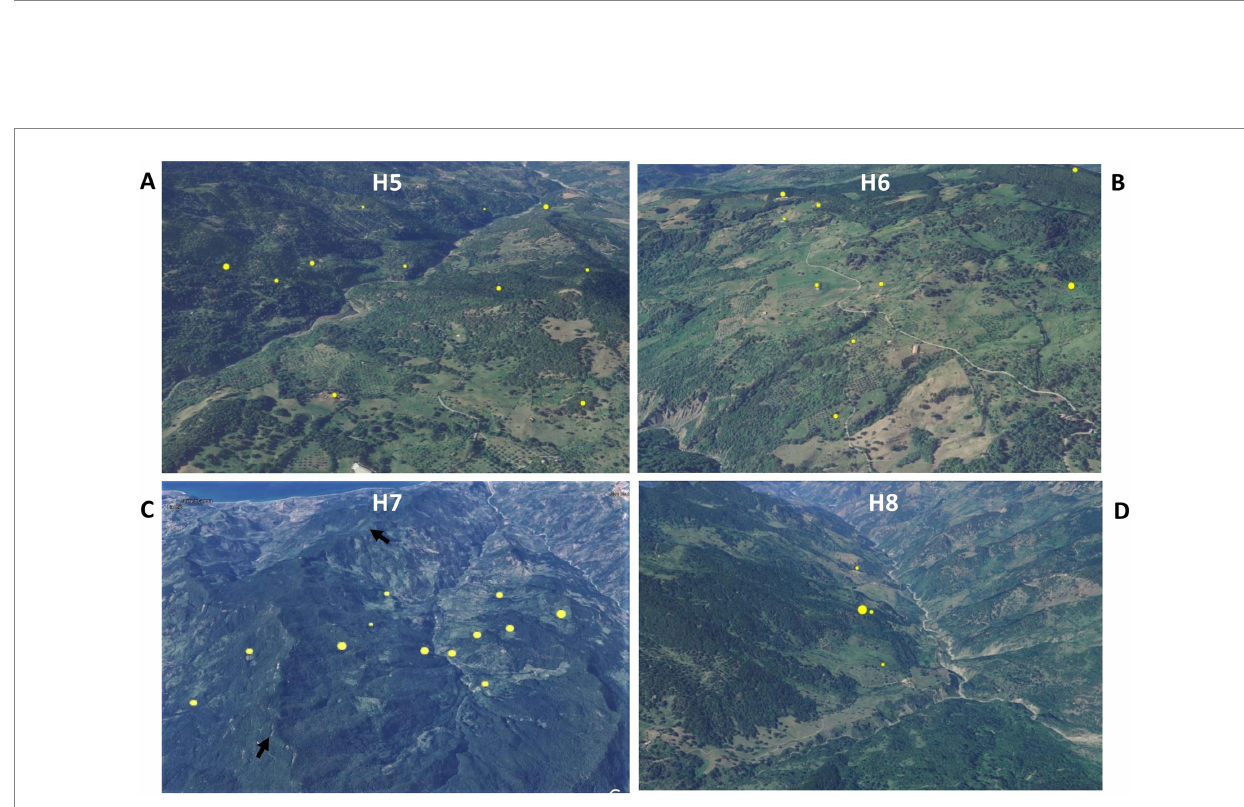
FIGURE 4 Satellite pictures of subareas H5–H8 (A–D) . Infected herds are shown as yellow dots the size of which is proportional to the number of infected animals per herd. The black arrows (C) indicate a rocky ridge. The maps were adapted from